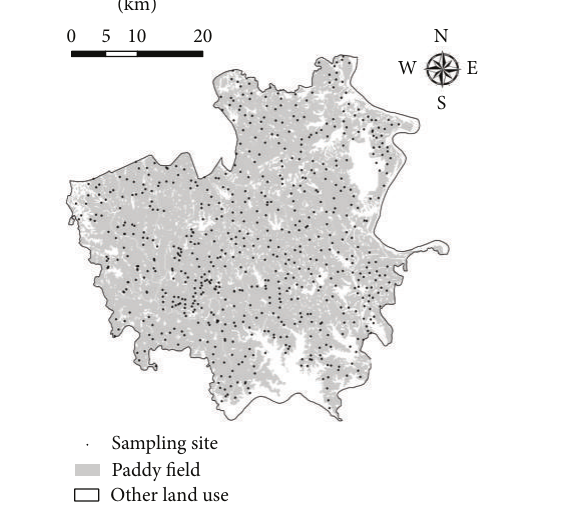
Figure 1: The study area and sampling